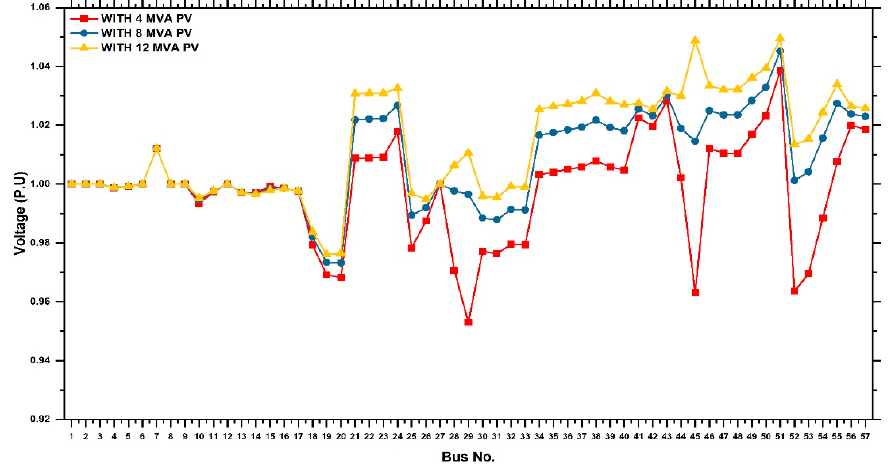
Figure 17. Voltage profile comparison of PV generators.